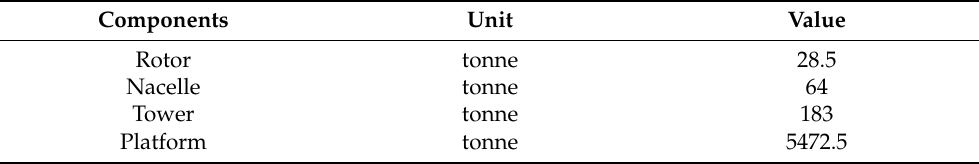
Table 3. Mass distribution of the barge-type floating wind turbine [33,43,44].